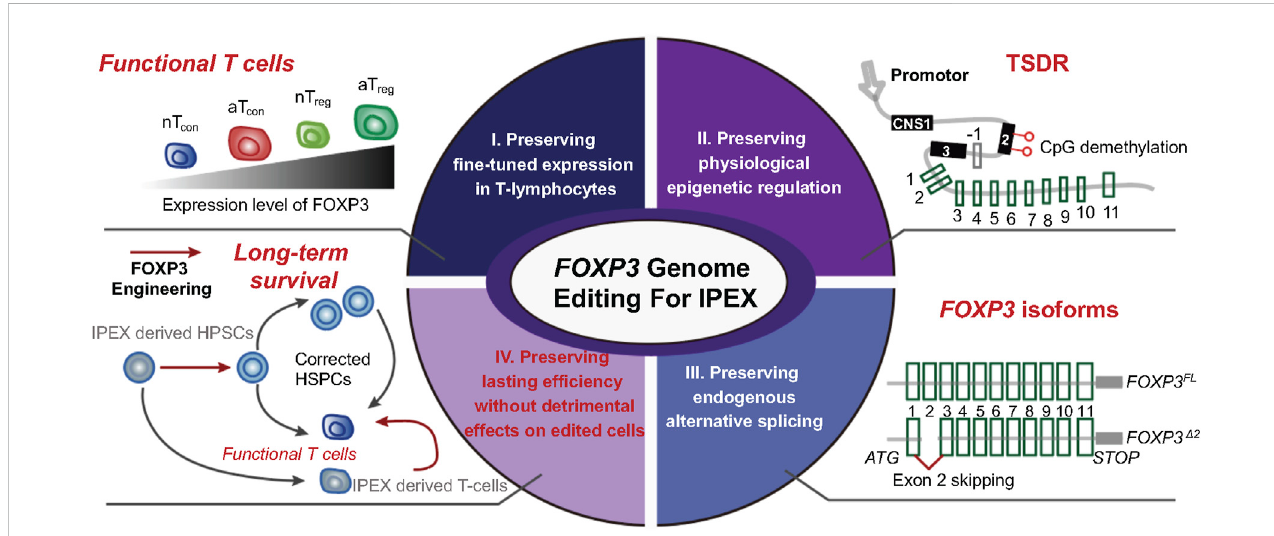
FIGURE 2 ChallengesofFOXP3genomeeditinginHSPCsfortherapeuticpurposes.SchematicrepresentationofvariousfeaturesoftheFOXP3gene,whichneedto be preserved to achieve therapeutic safety and ef fi cacy. nT, natural occurring regulatory or conventional T cells, aT, activated regulatory or conventional T cells, TSDR, Treg speci fi c demethylated region, CNS, conserved non-coding sequence elements. Inspired from Figure 2, Porteus et al.